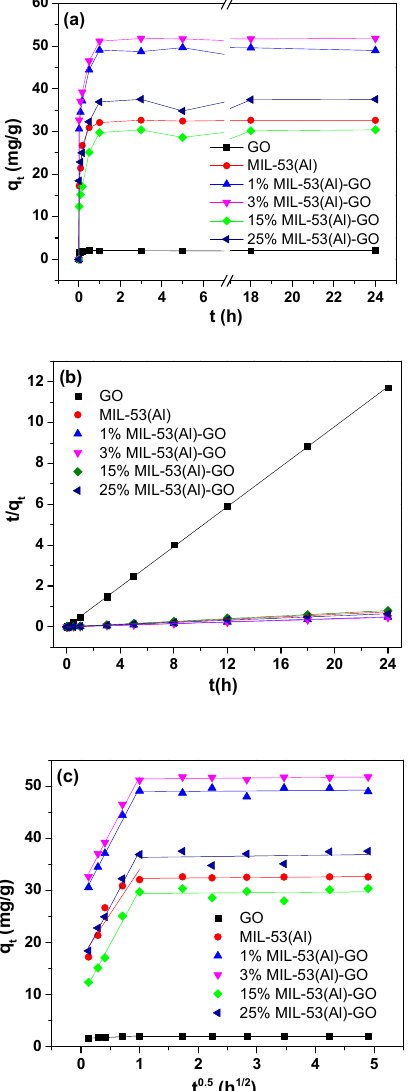
Figure 2. ( a ) Adsorption capacity of As(III) as a function of contact time, ( b ) pseudo-second-order plots, and ( c ) intra-particle diffusion for As(III) adsorption on GO, MIL-53(Al), and MIL-53(Al)-GO